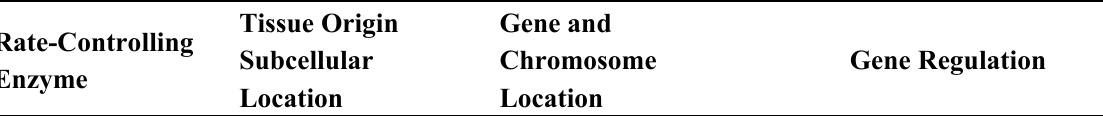
Table 1. Rate-controlling enzymes of heme biosynthesis, catabolism and major mechanisms for their